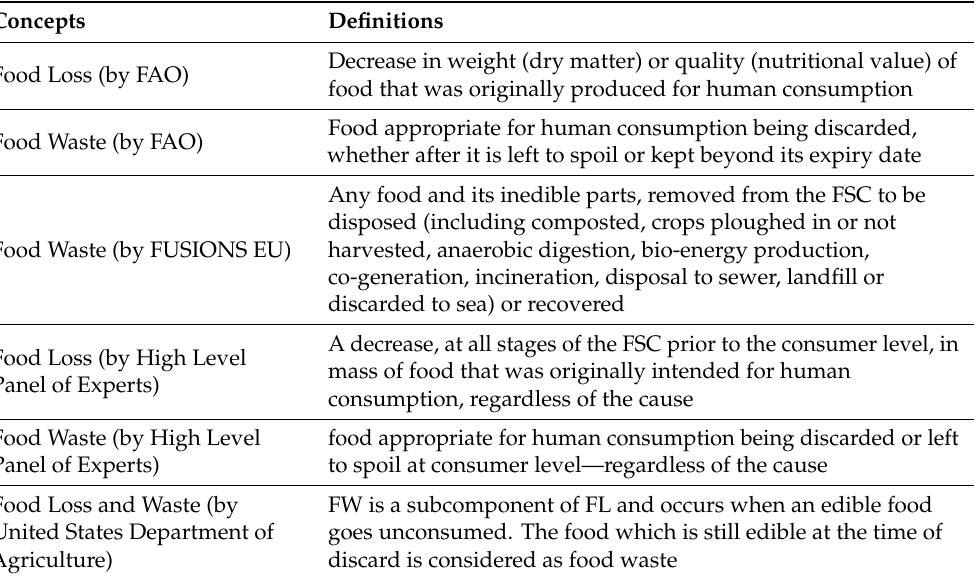
Table 1. Definitions of Food Loss and